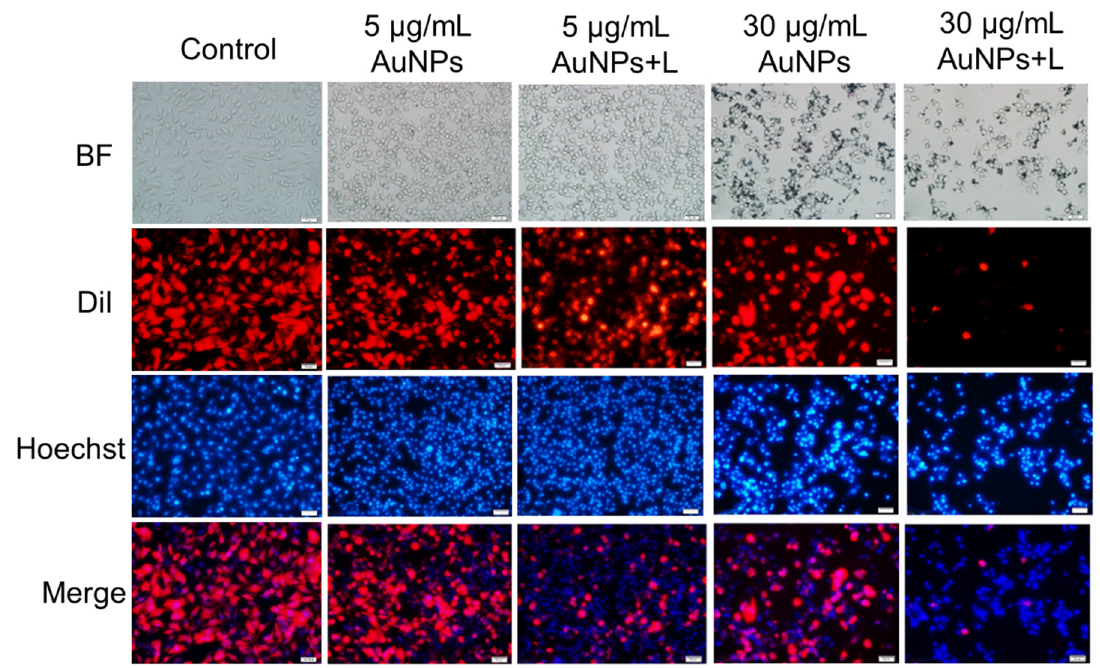
Figure 5. The change in morphology of nucleus and plasma membrane in MDA-MB-231 cells upon exposure to HA-capped AuNPs (with/without NIR lighting) at different Au concentrations, according to a Hoechst/DiI double staining assay. Scale bar represents 50 μ m.